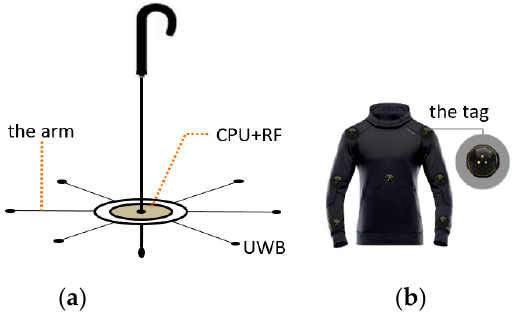
Figure 1. Positioning umbrella and receiving tags. ( a ) Positioning umbrella. ( b ) Receiving tags attached on clothes.